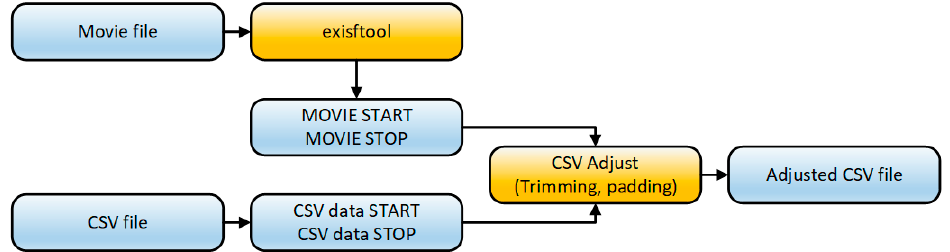
Figure 11. RW events synchronization process.